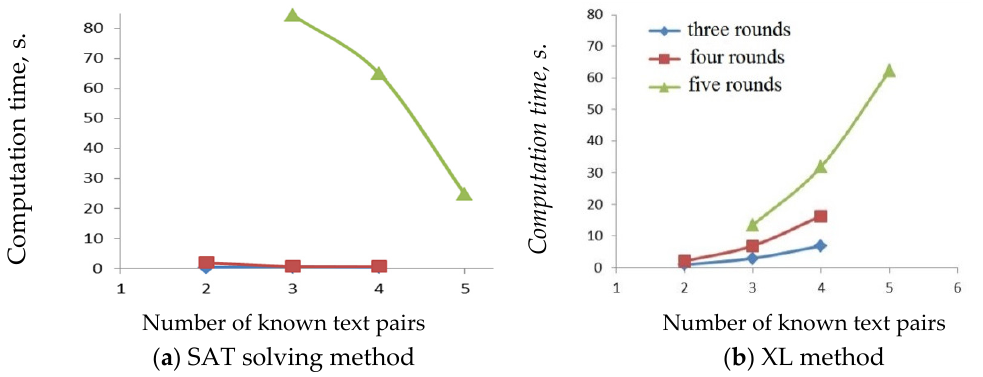
Figure 6. Search complexity with different numbers of Magma rounds.